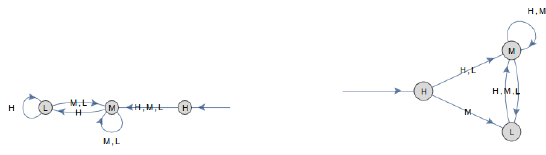
Figure 6: Top two strategies: 23% & 10%